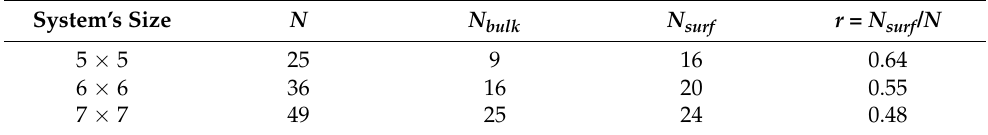
Table 2. Values of the ratio r between the number of surface atoms N surf and the total number of atoms N for 5 × 5, 6 × 6, and 7 × 7 lattices.